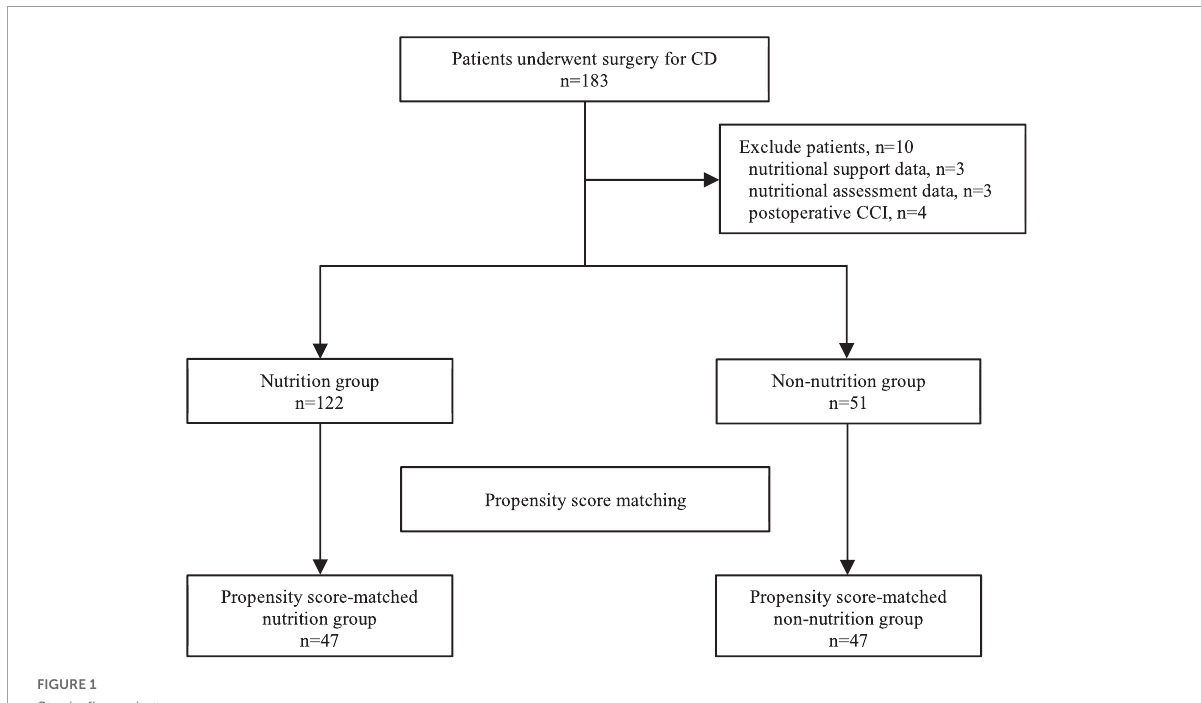
FIGURE1 Study flow